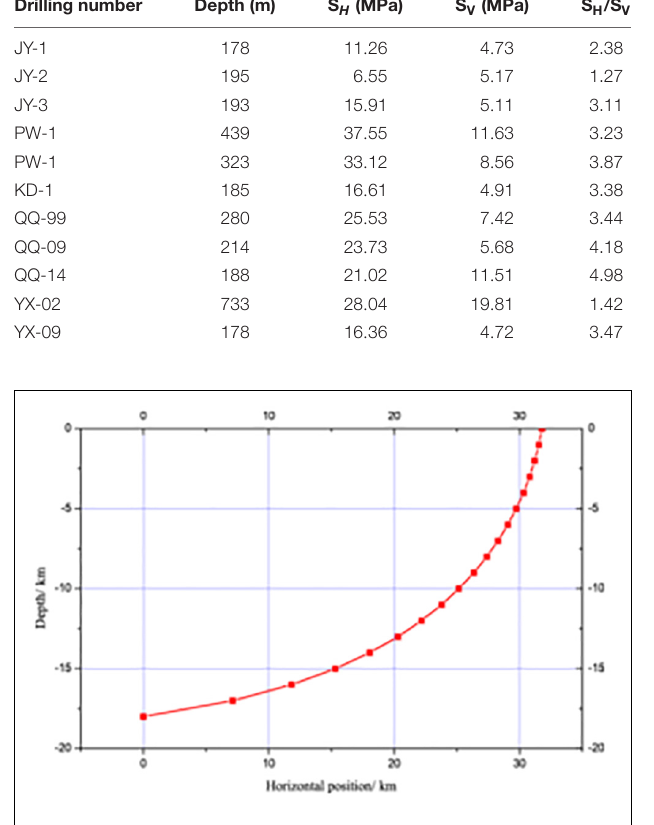
TABLE 2 | Stress measurement values of the Longmen mountain fault zone QQ (Chen et al., 2012; Qin et al., 2018). Drilling number